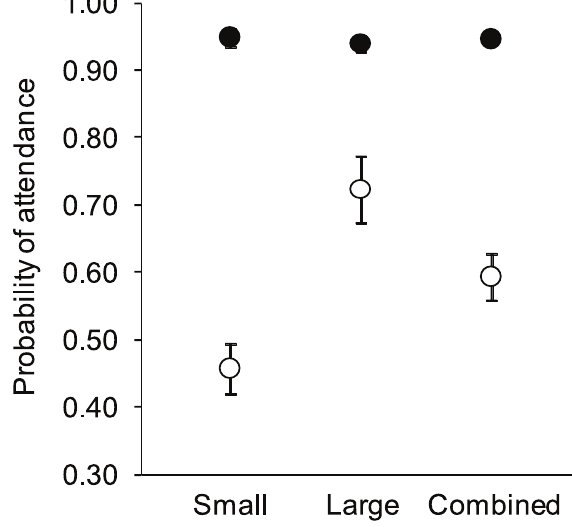
Figure 3. Probability of carcass attendance depending on prey size and season. Points represent the mean probability of attendance for a monitored wolf at the carcass of a small ungulate ( # 130 kg), large ungulate ( . 130 kg), or all ungulate carcasses combined. Open circles represent summer months and filled circles represent winter months. The error bars represent standard errors, some of which are too small to see.